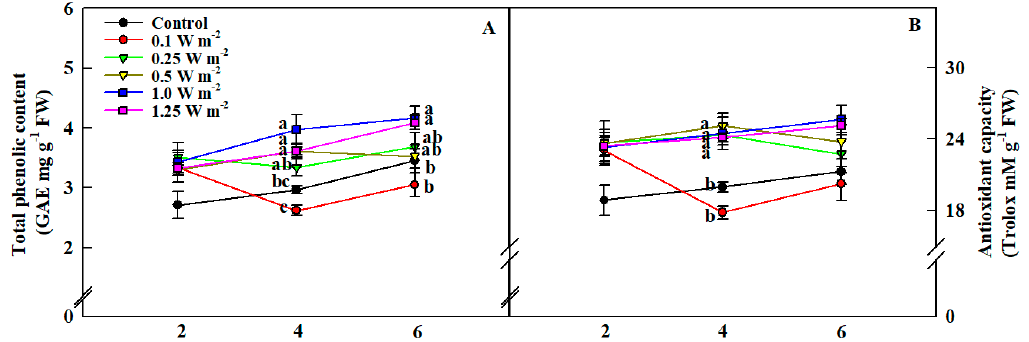
Figure 5. Total phenolic content ( A ) and antioxidant capacity ( B ) per unit fresh weight of C. denticulatum subjected to five different energy of UV-B radiation for 6 days. The UV-B treatments started after 5 weeks of transplanting. Different letters above bars indicate a significant difference by Duncan’s multiple range test at p < 0.05 ( n = 6).